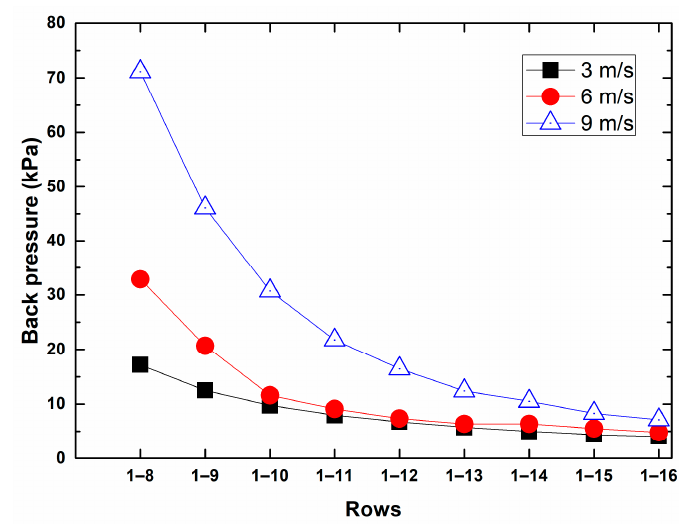
Figure 9. Variation of the backpressure with the number of ACC cells under different ambient winds in winter.